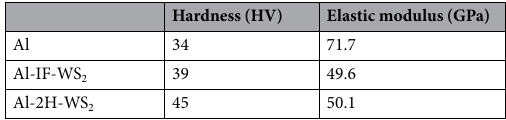
Table 2. Mechanical properties of the